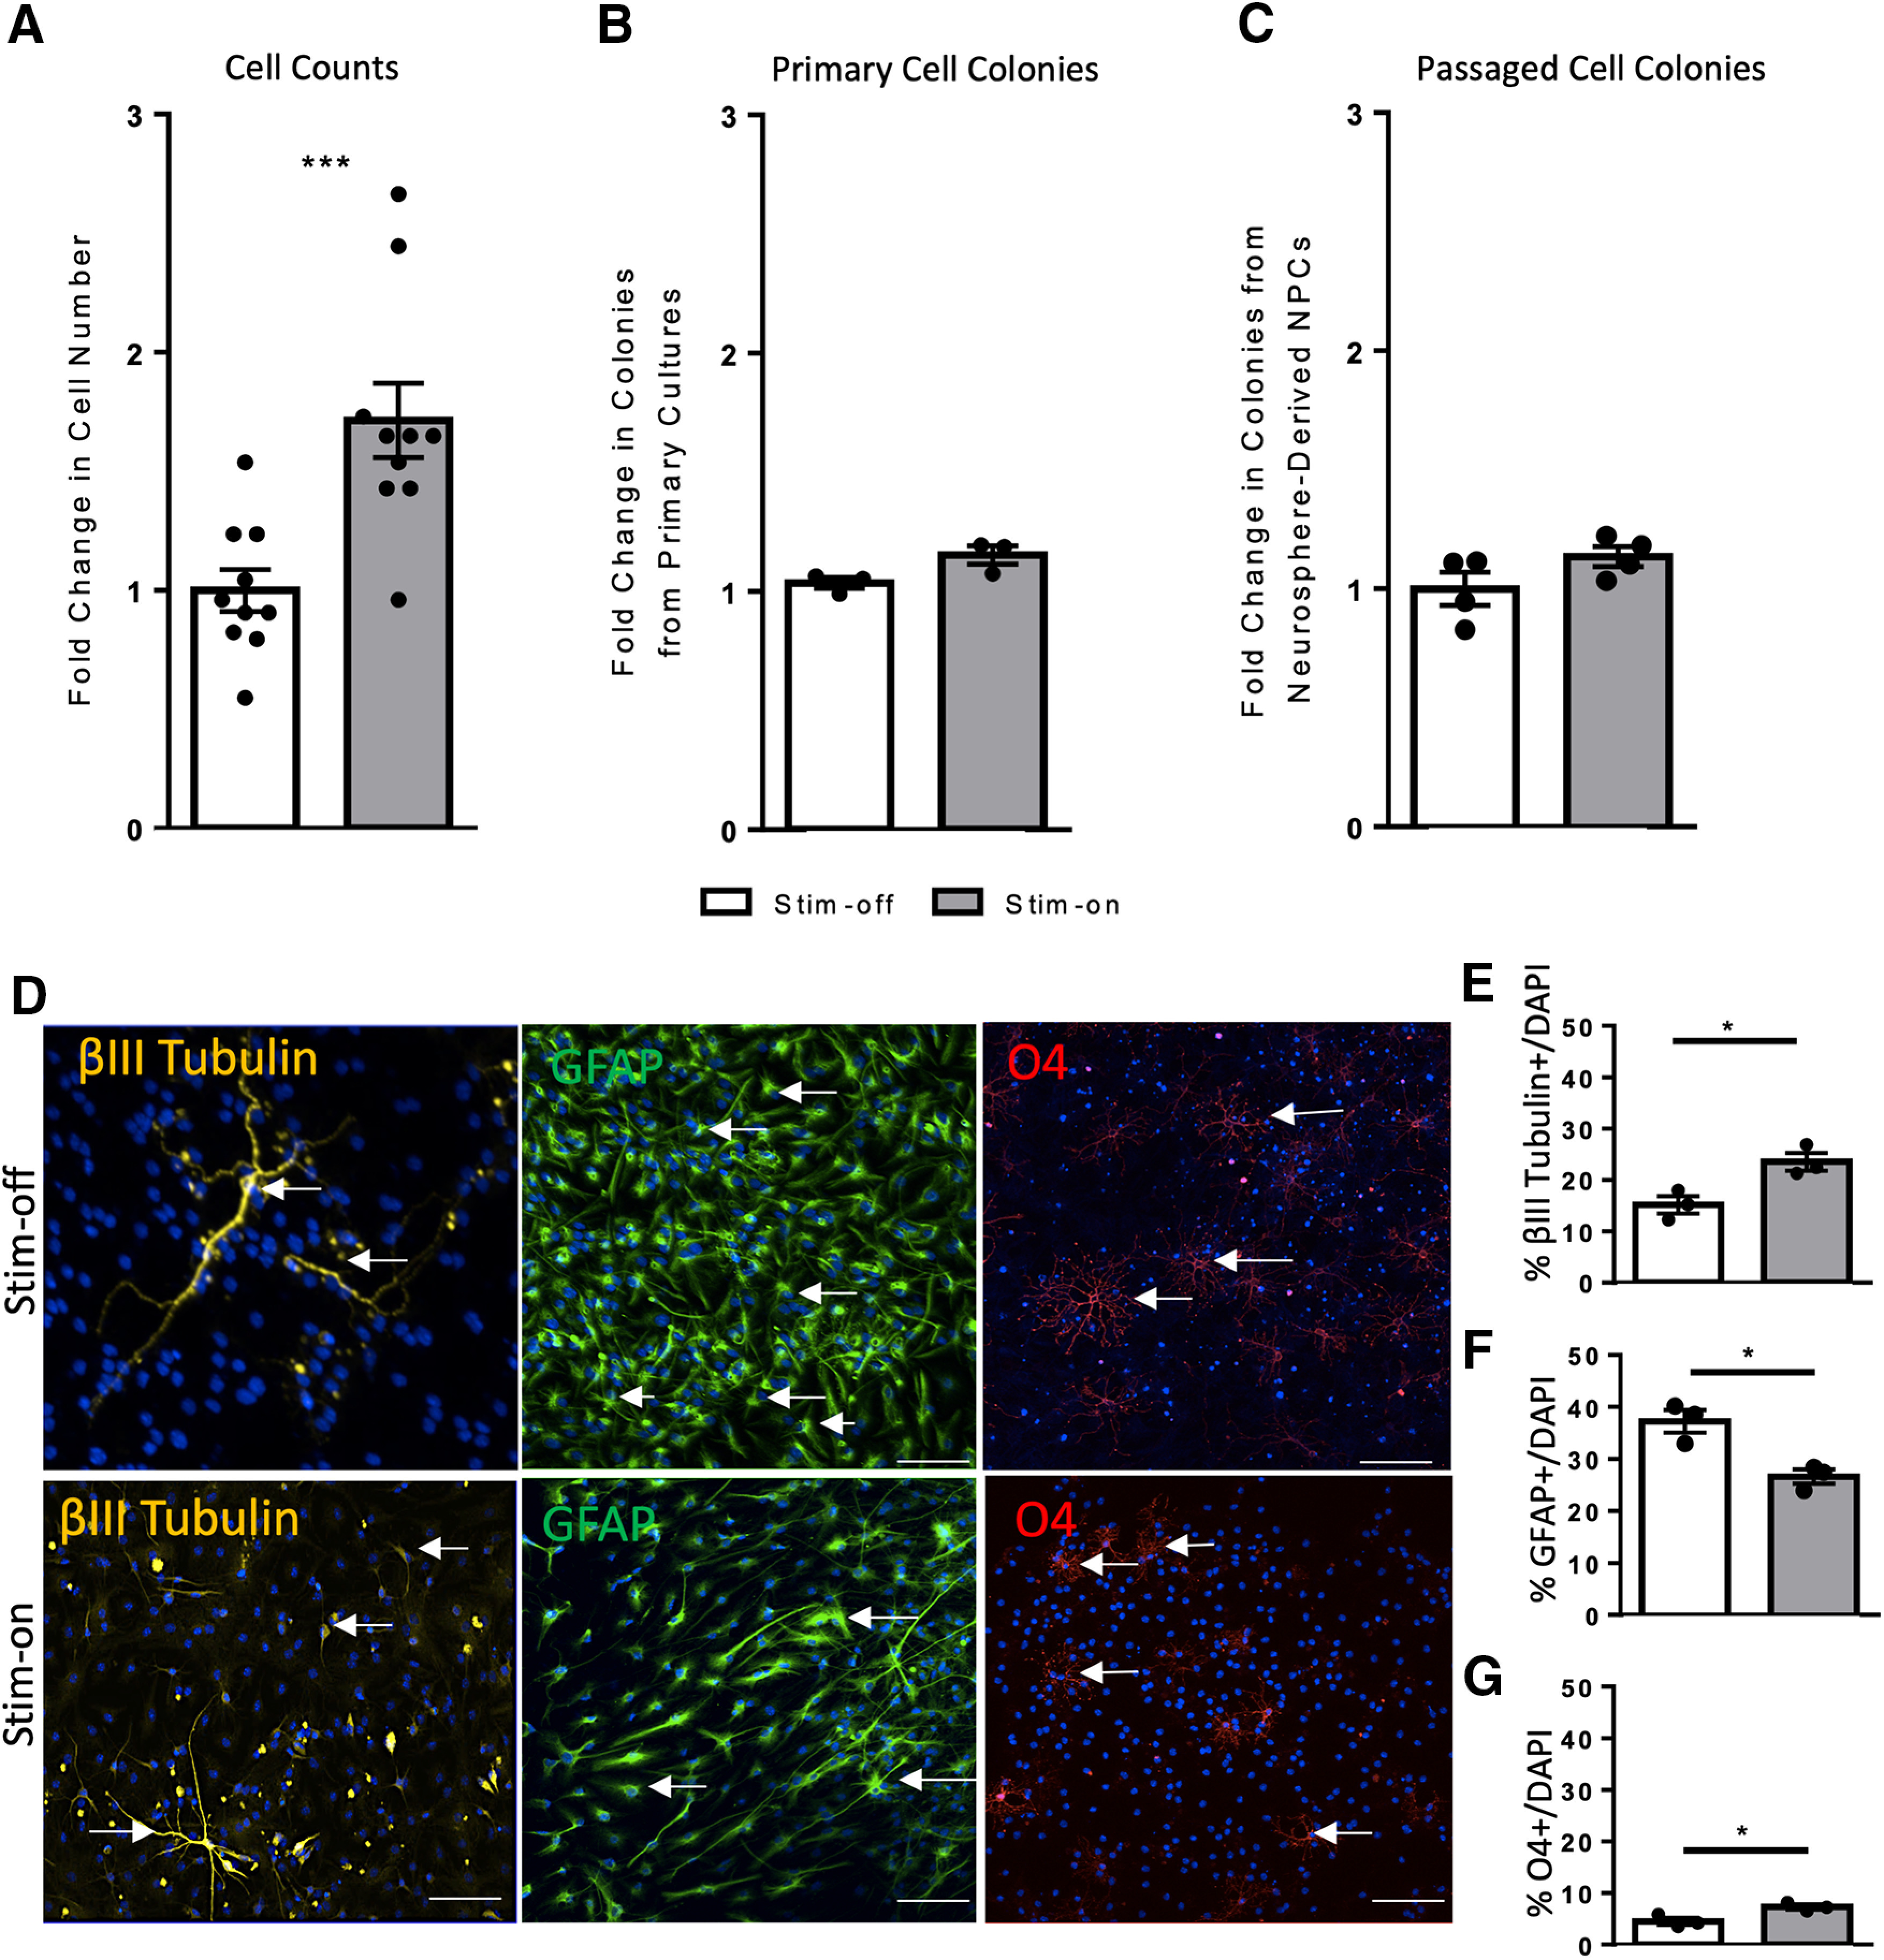
In vitro electrical stimulation increases cell number and regulates NPC differentiation. A, A 1.7-fold increase in the number of living cells is seen following stim-on when compared with the stim-off cells processed the same way (62,400 ± 5705 vs 36,400 ± 3205 cells, stim-on vs stim-off respectively; n = 10 individual experiments; ***p = 0.0009). B, C, Fold change in the number of colonies from stim-off and stim-on in (B) primary cells (p = 0.06; n = 3 independent experiments) and (C) neurosphere-derived NPCs (p = 0.1; n = 4 independent experiments). Neurosphere counts from in vitro stimulation found in Extended Data Figure 1-1. D, Differentiated neurospheres stained for βIII tubulin (neurons), GFAP (astrocytes), and O4 (oligodendrocytes). White arrows indicate examples of cells co-localized with DAPI (blue). Scale bar = 100 µm. E–G, Quantification of cells as a percent of DAPI (n = 10 spheres/treatment, 3 mice per group) expressing (E) βIII tubulin (*p = 0.02), (F) GFAP (*p = 0.01), and (G) O4 (*p = 0.03). Each point in the graph represents an independent experiment, plotted with mean ± SEM. All analysis performed via a two-tailed unpaired t test between stim-off and stim-on.